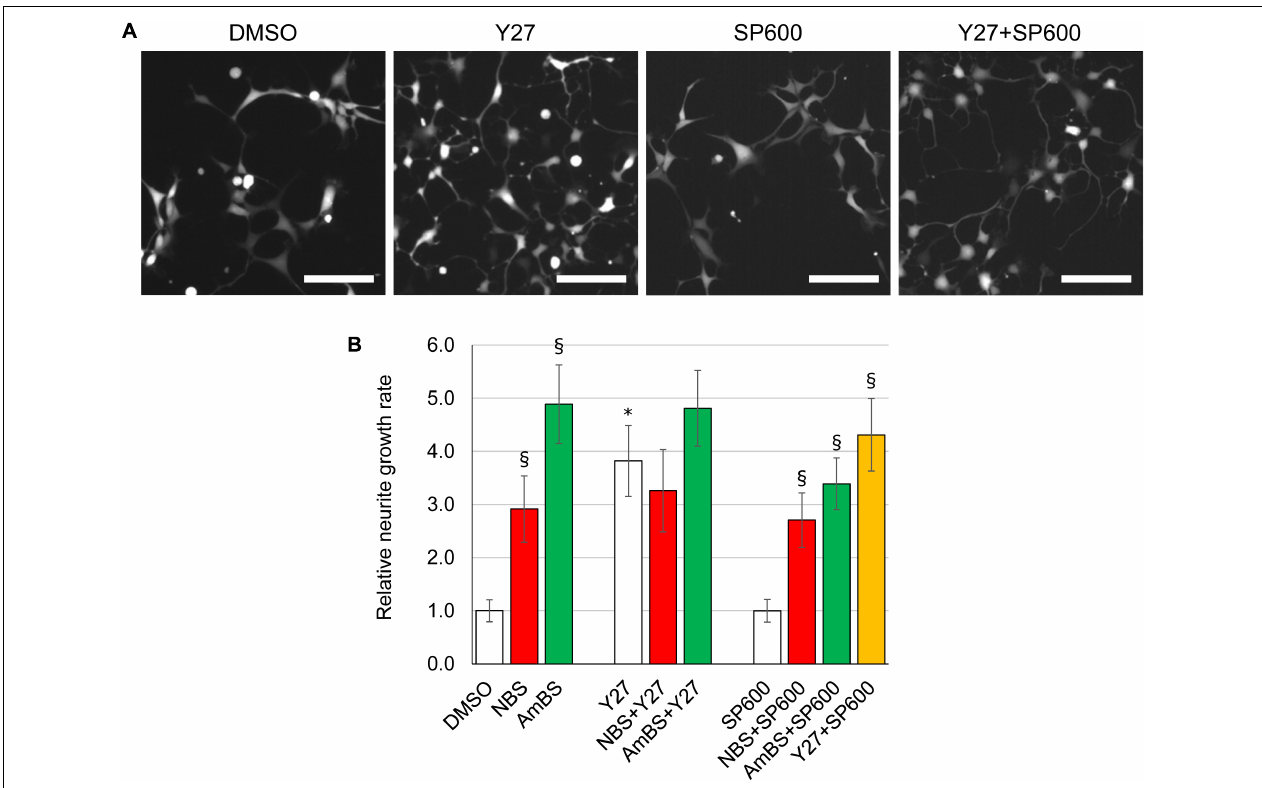
FIGURE 5 | Effect of potential upstream regulators on basal and BS derivative-stimulated neurite outgrowth. (A) Representative images of eGFP-NPCs treated with vehicle (DMSO), 10 µ M Y27632 (Y27, ROCK1 inhibitor), 10 µ M SP600125 (SP600, JNK inhibitor), or with the combination of Y27 and SP600. Images were acquired 4 h after treatment. Scale bars indicate 10 µ m. (B) The neurite outgrowth rates were determined in NPCs treated with NBS, AmBS, Y27, SP600, or combinations of those inhibitors. Vehicle control (DMSO) was used as a reference point. The ROCK1 inhibitor stimulated neurite outgrowth to similar extent to that seen with NBS and AmBS. In contrast, JNK inhibition had no effect on neurite outgrowth. When NBS was co-administered with Y27632 or SP600125, neither additivity nor inhibition was seen. Similar results were obtained with AmBS. Similar to NBS and AmBS, SP600125 did not alter Y27632-stimulated neurite outgrowth. All panels depict the means ± SEM from 3 to 5 independent experiments. Asterisks indicate significant differences as compared to the DMSO control, whereas section signs mark significant differences as compared to samples, which are not treated with NBS or AmBS in the same group ( p <